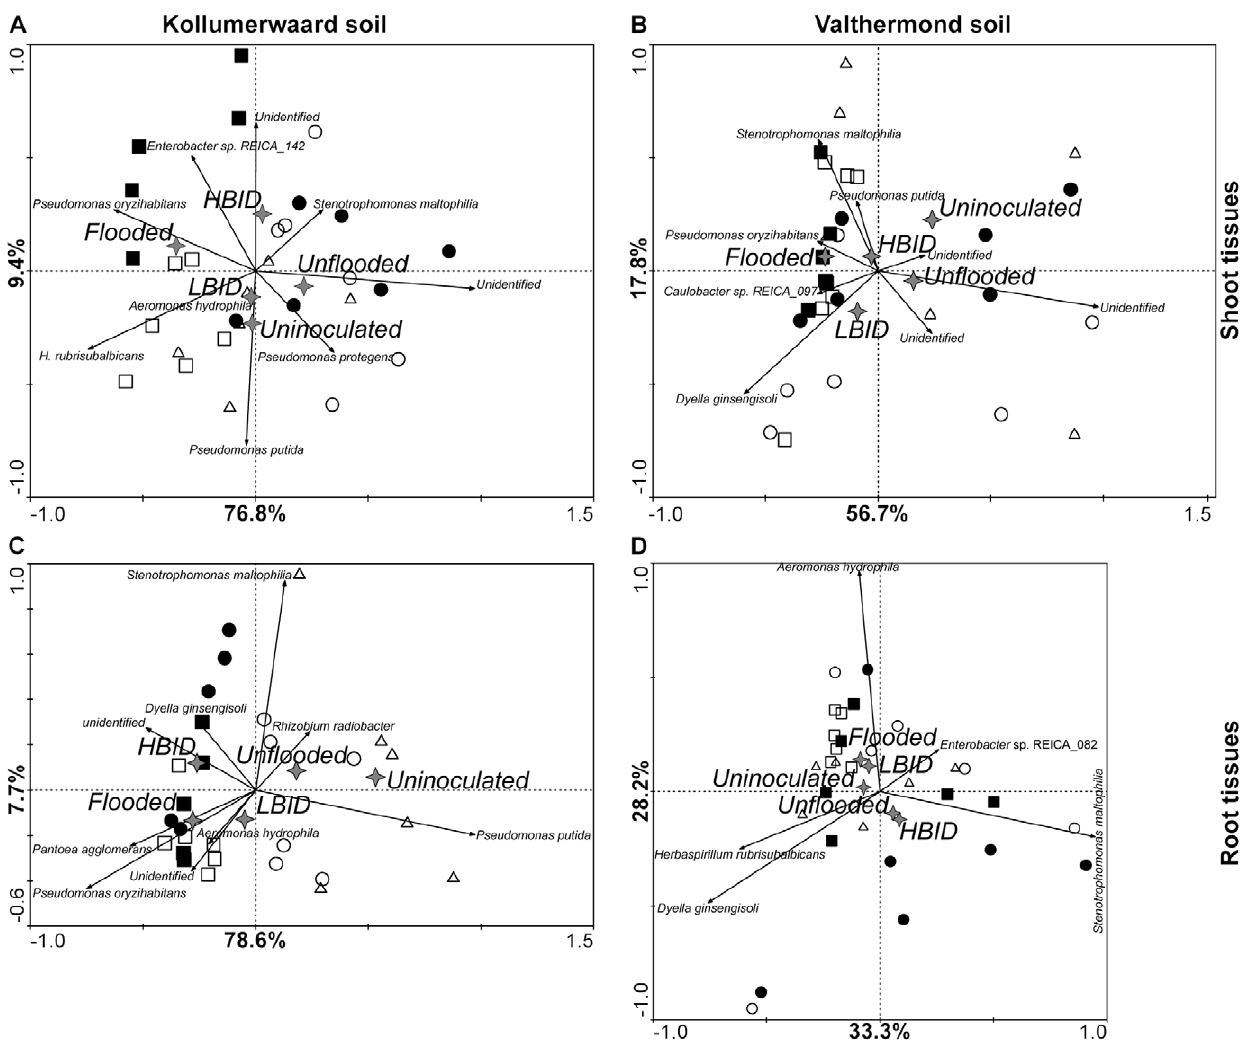
Figure 3. Biplot ordination diagrams of rice shoot and root bacterial endophytes. RDA diagrams generated from PCR-DGGE profiles of endophytic bacterial community sampled from shoot (A and B) and root (C and D) tissues of plants cultivated on K (A and C) and V (B and D) soils are shown. Squares and circle represent PCR-DGGE patterns of bacterial communities from plants submitted to, respectively, flooded and unflooded regimes and exposed to low- (empty symbol) and high- (full symbol) BID. Triangles (control treatment) represent PCR-DGGE patterns of bacterial communities from plants submitted to unflooded regime and cultivated in uninoculated soils. Six replicates of each treatment are shown. Stars represent nominal environmental variables. Arrows represent PCR-DGGE bands in which only the most descriptive communities are shown.